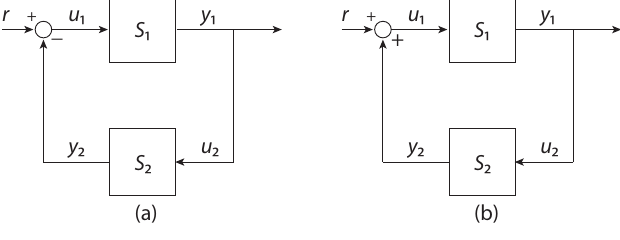
Figure 2. ( a ) Feedback interconnection with negative feedback. ( b ) Feedback interconnec- tion with positive feedback.